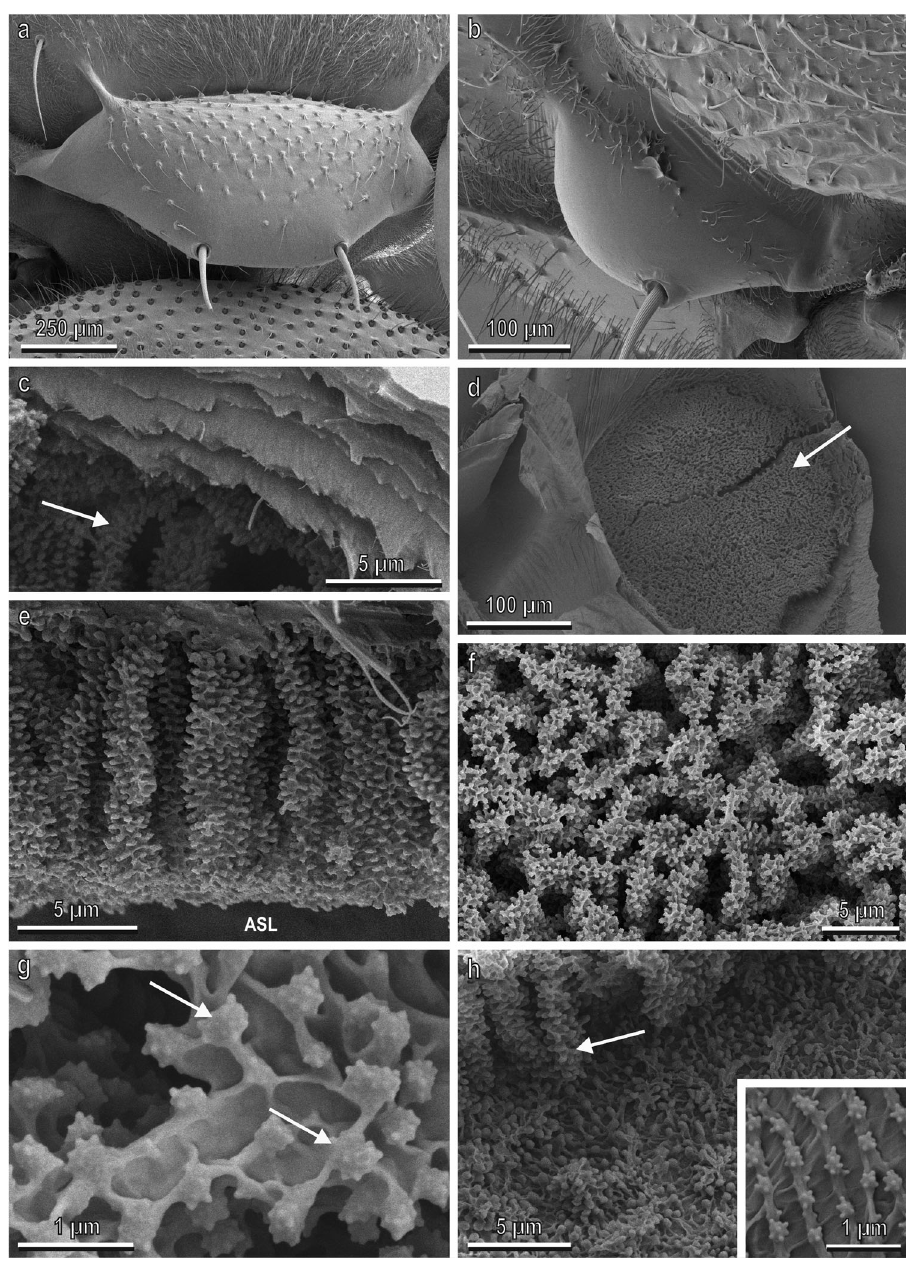
Fig. 4 Scutellum of adults of Bactrocera oleae ten days old visualised with Cryo SEM. a Dorsal vision of the scutellum; b Dorsal view of the notopleural callus. Note the cuticular surface with reduced or absent microtrichia in comparison with other body areas; c Detail of the multi-layered transparent cuticle located on the white thoracic patches under which air sacs with arborisations (arrow) are present; d Internal vision of the air sac located under the katatergite. Note the prominent arborisations under the transparent cuticle (arrow); e Lateral view of the long arborisations of the inner portion of the air sac facing the air sac lumen (ASL) under the transparent cuticle; f Detail of the arborisations visualised from the internal side (lumen) of the air sac; g Detail of the arborisations characterised by the presence of numerous spiny beads (arrows); h Detail of ( d ) showing that the arborisations of the air sacs (arrow) are present only under the transparent cuticle (corresponding to the white patches) while, in correspondence of the dark cuticle, no arborisation is present and the walls of the air sac show only scattered